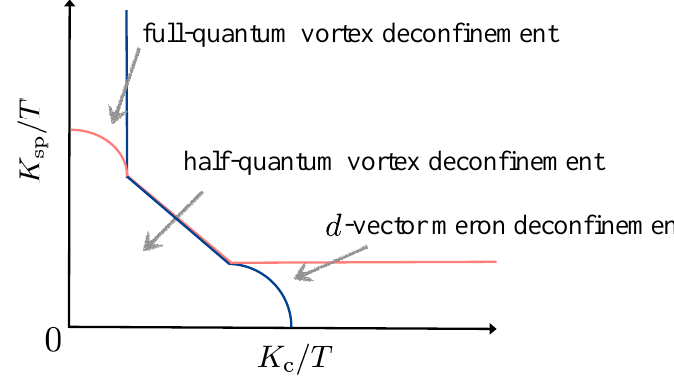
Figure 2: Three distinct Bereziskii-Kosterlitz-Thouless transitions driven by decon- / T , K / T ) plane, where the ar- finements of three different types vortices in the ( K sp c row directions correspond to increasing temperature and the blue (red) curve indi- cates phase transition in the charge (spin) sector. Deconfinements of full-quantum vortex and d -vector meron leads to the exponentially decaying phase coherence of charge order and spin order, respectively, whereas deconfinement of half-quantum vortex the exponentially decaying phase coherence of both